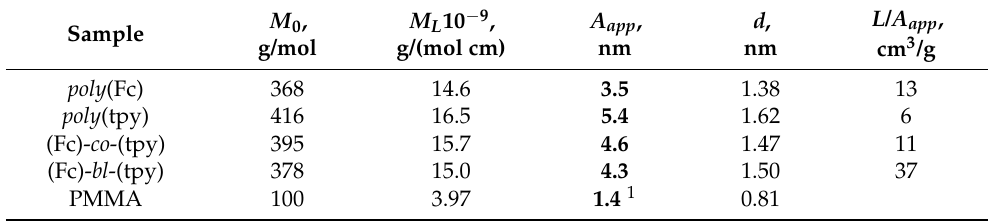
Table 4. Summary of the conformational parameters evaluated for the studied macromolecules. Sample